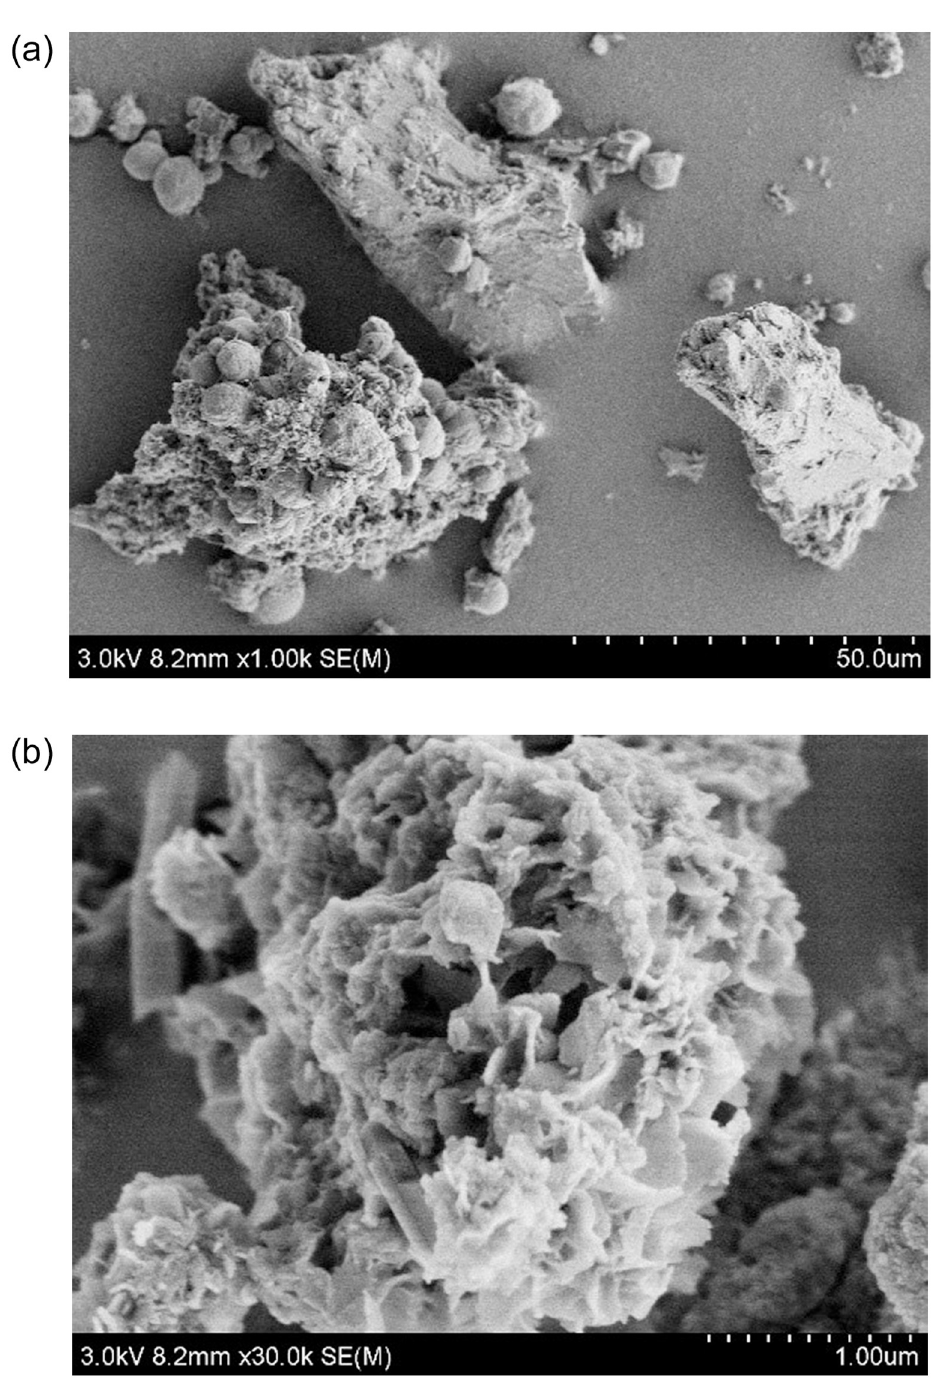
Fig 7. Morphology of induced calcite in shake flask solution. (a): SEM at 50.0um;(b): SEM at 1.0